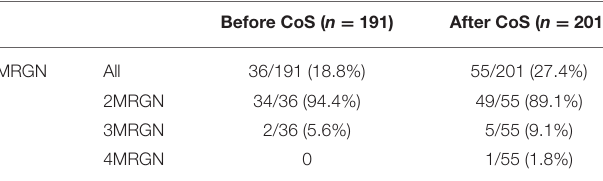
TABLE 3 | Comparison of very low birth weight infants (VLBWI) with multidrug-resistant Gram-negative bacteria (MRGN) detected by rectal swabs on the day of admission before the introduction of colonization screening (CoS) and VLBWI with MRGN detected by CoS (i.e., rectal swabs collected on the day of admission and repeated weekly) after its